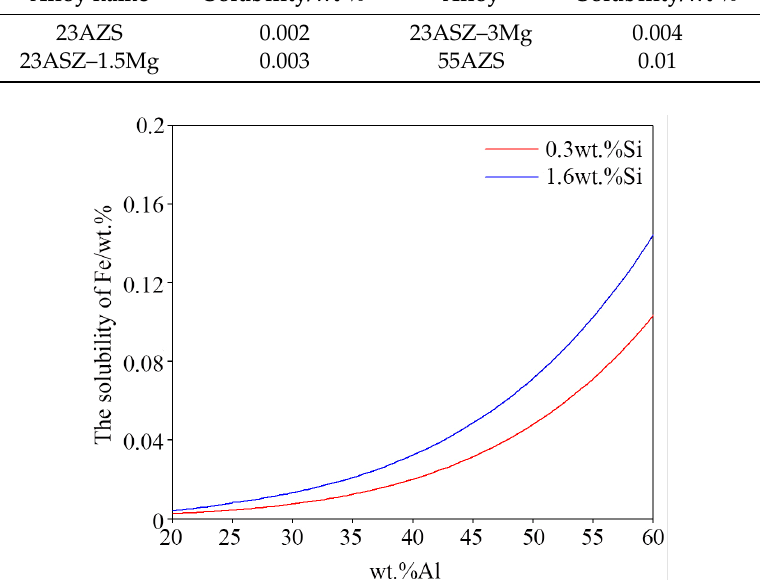
Figure 19. The solubility of Fe in bath with different Al content.